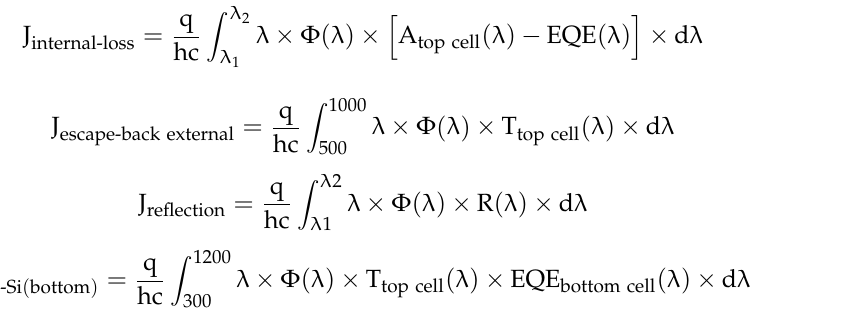
Figure 1. Device structures of the four-terminal perovskite/silicon tandem solar cell are shown.